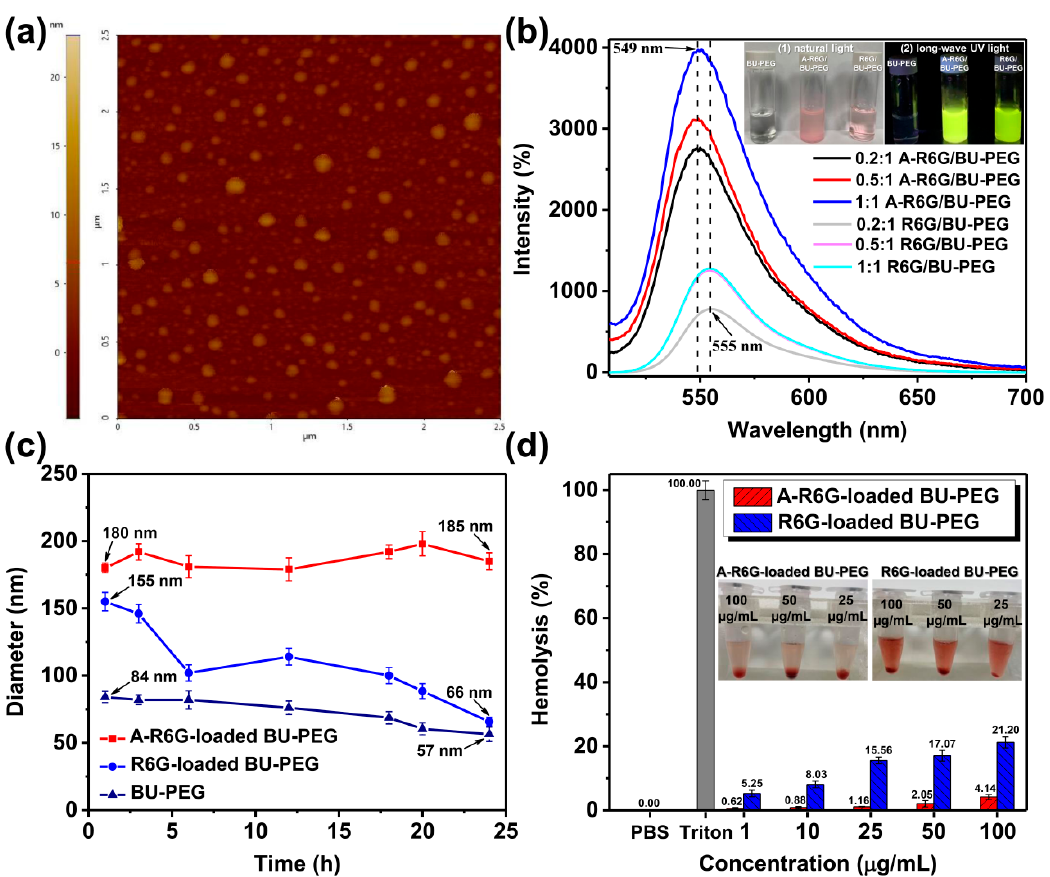
Figure 2. ( a ) AMF images of A-R6G-loaded BU-PEG nanogels measured at 25 ◦ C. ( b ) PL spectra of A-R6G-loaded and R6G-loaded BU-PEG nanogels in water at 25 ◦ C. Inset: photographs of A-R6G-loaded and R6G-loaded BU-PEG nanogels in water exposed to (1) natural lighting and (2) broadband UV lighting conditions. ( c ) Time-dependent DLS analysis of the structural stability of A-R6G-loaded and R6G-loaded BU-PEG nanogels in media containing 10% FBS at pH 7.4 for 24 h. ( d ) In vitro hemolytic assay of different concentrations of A-R6G-loaded and R6G-loaded BU-PEG nanogels on SRBCs. Inset: photographs showing SRBCs incubated with varying concentrations (1–100 µ g/mL) of A-R6G-loaded or R6G-loaded BU-PEG nanogels at 37 ◦ C in 5% CO 2 for 4